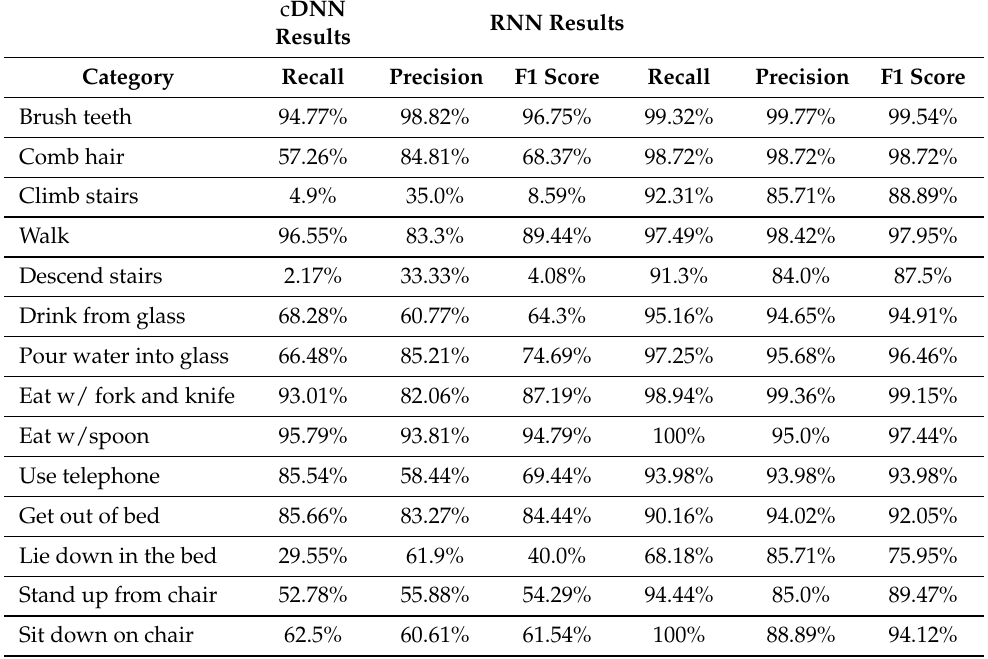
Table 6. Results of both DNN and RNN for specific movements of wrist-worn data.